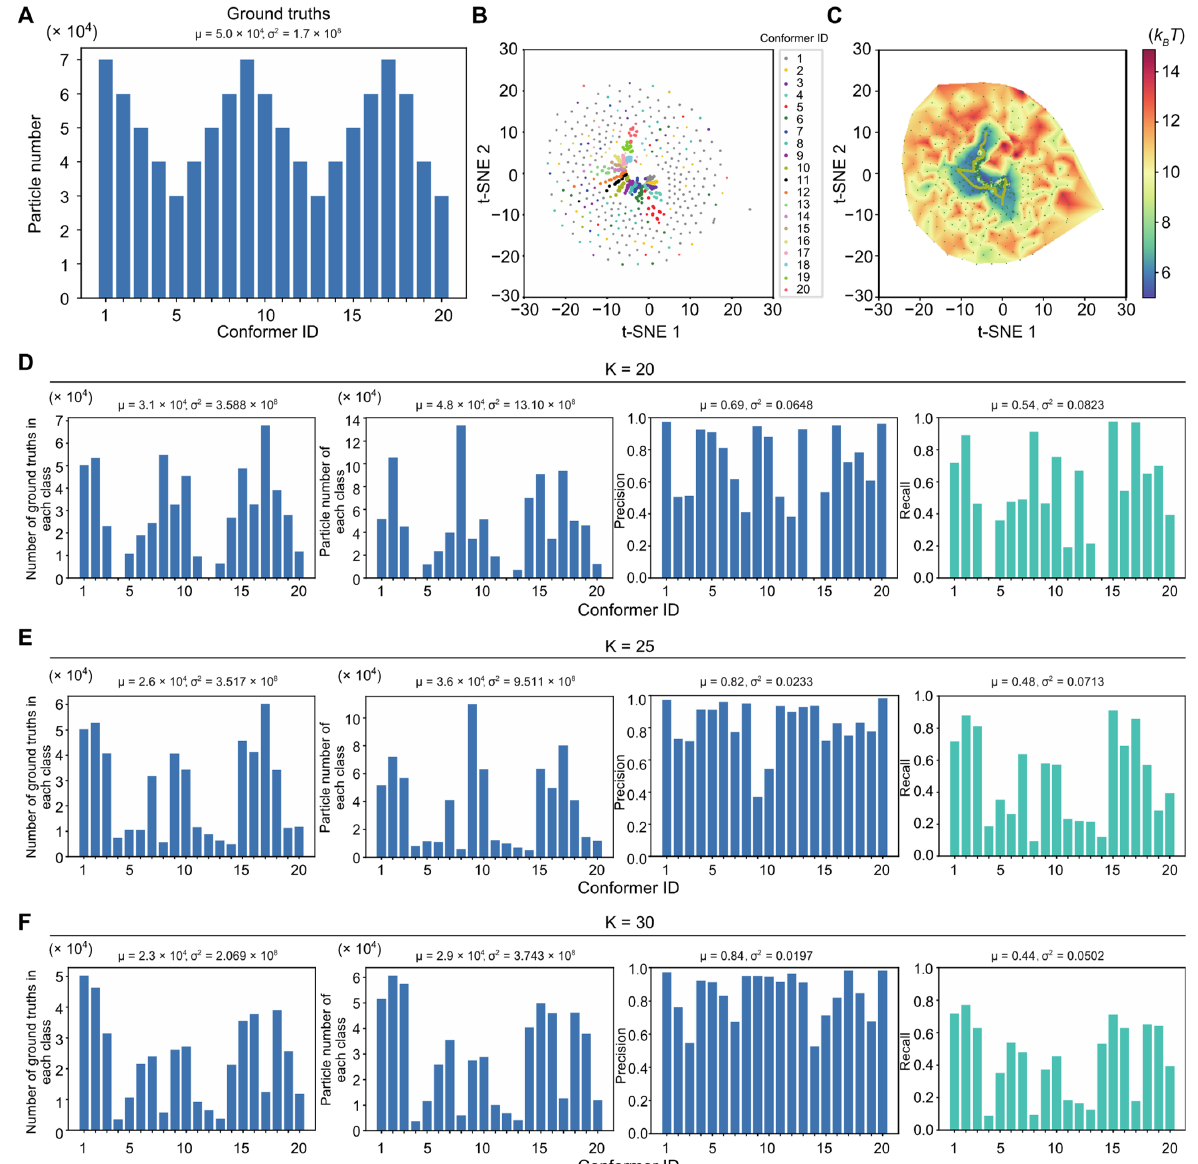
Figure 4. Performance evaluation of 3D classification by AlphaCryo4D on the synthetic dataset with non-uniform distribution of conformational continuum. ( A ) The non-uniform distribution of 20 conformers of another simulated NLRP3 dataset at an SNR of 0.01 was used to examine the performance of AlphaCryo4D. This dataset was utilized to calculate the pseudo-energy landscape shown in panels ( B , C ) and its corresponding outcome of 3D classification by AlphaCryo4D shown in panels ( D – F ), which tests the robustness of AlphaCryo4D in the case of non-uniform distributions of the underlying conformational states. ( B ) Dimensionality reduction of resampled 3D volumes and their corresponding feature maps from the simulated dataset by t-SNE. The colors of data points indicate the ground truth of their corresponding 3D volumes. ( C ) Reconstruction of the pseudo-energy landscape of the simulated NLRP3 dataset. ( D – F ) The number of correctly classified particles in each class, the particle number of each class, the precision of 3D classification and the corresponding recall of AlphaCryo4D blind tests using this simulated dataset when the class number is set to 20 ( D ), 25 ( E ) and 30 ( F ).